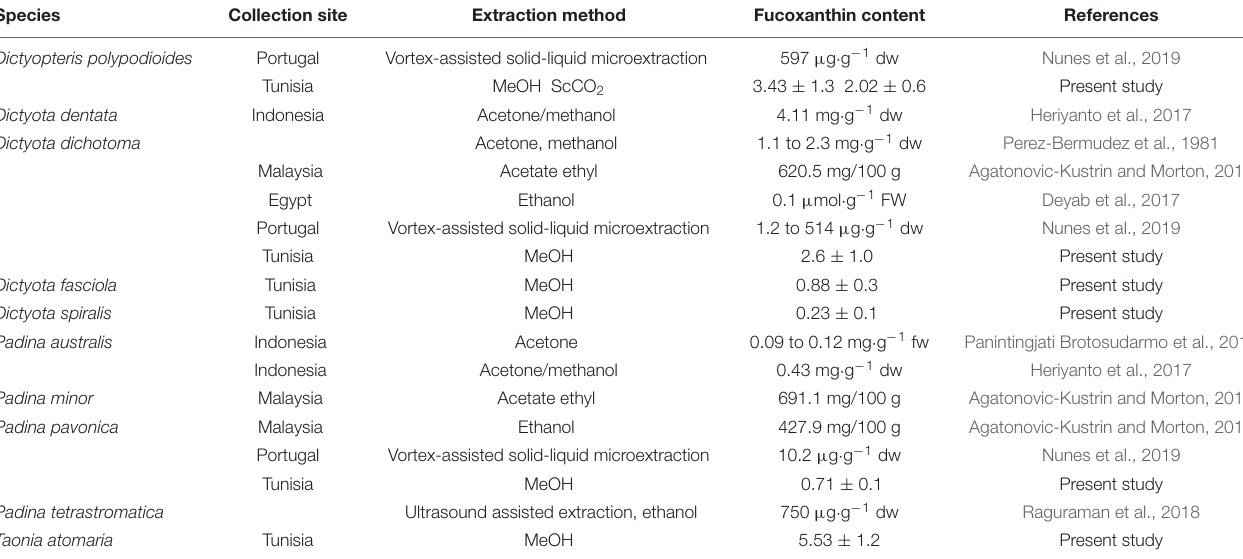
TABLE 5 | Reported fucoxanthin content of Dictyotales species in literature and in the present